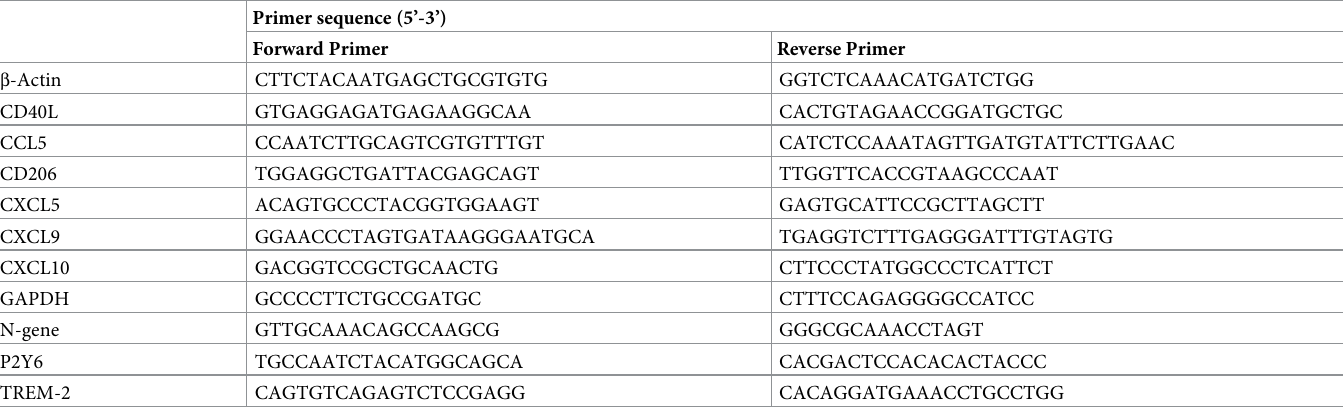
Table 1. Sequence of Primers used in the